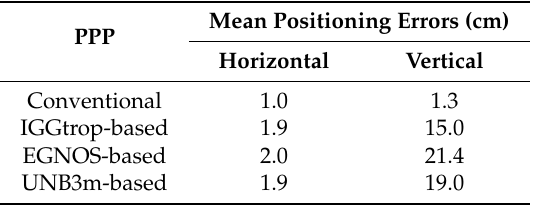
Table 2. Statistical results of the mean positioning errors in vertical and horizontal components of the conventional PPP, IGGtrop-based, EGNOS-based and UNB3m-based PPP solutions at 21 stations through 2012, respectively. Mean Positioning Errors (cm) PPP Horizontal Vertical